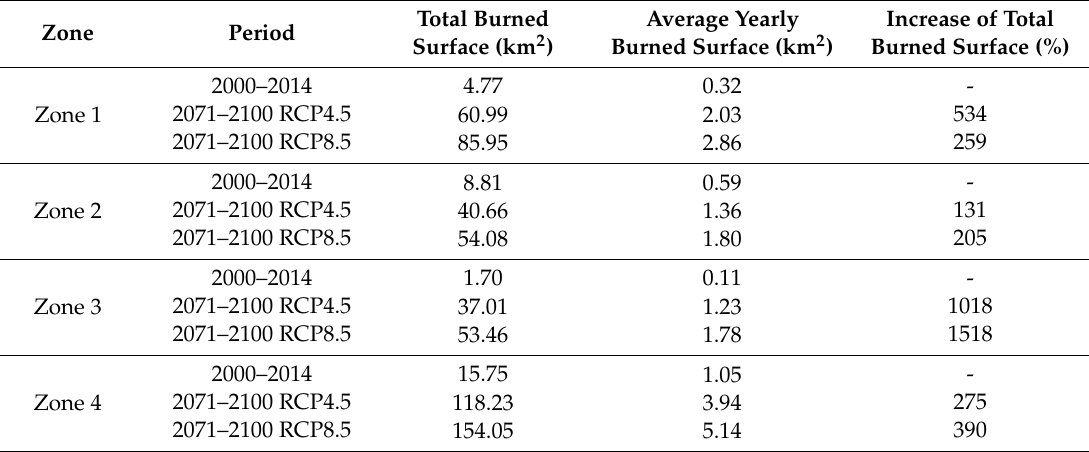
Table 10. Comparison of historical (2000–2014) and predicted (2071–2100, both RCP4.5 and RCP8.5 scenarios) burned surface in wildfires larger of 30,000 m 2 . Increase of total burned surface is related to baseline period